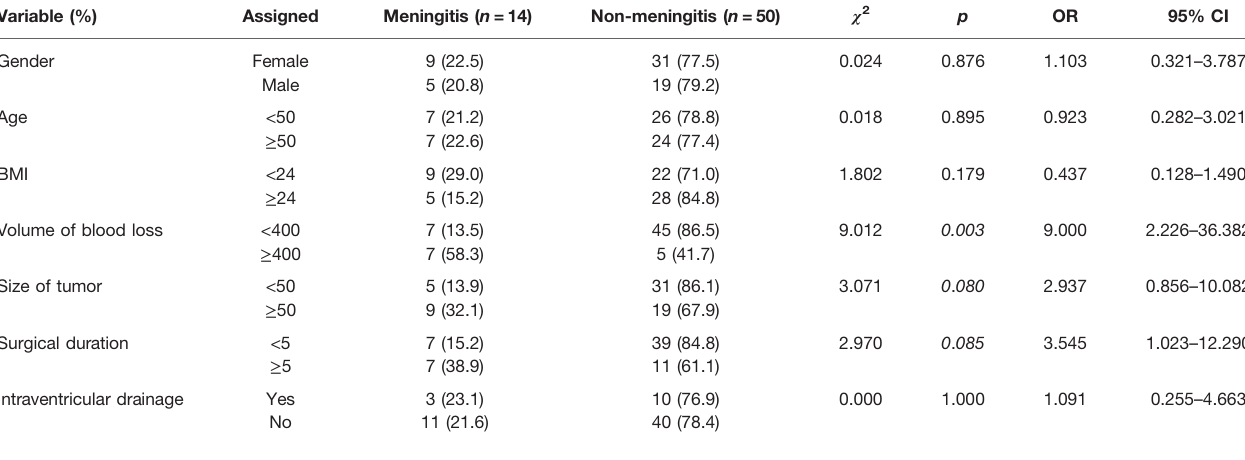
TABLE 2 | The results of univariate